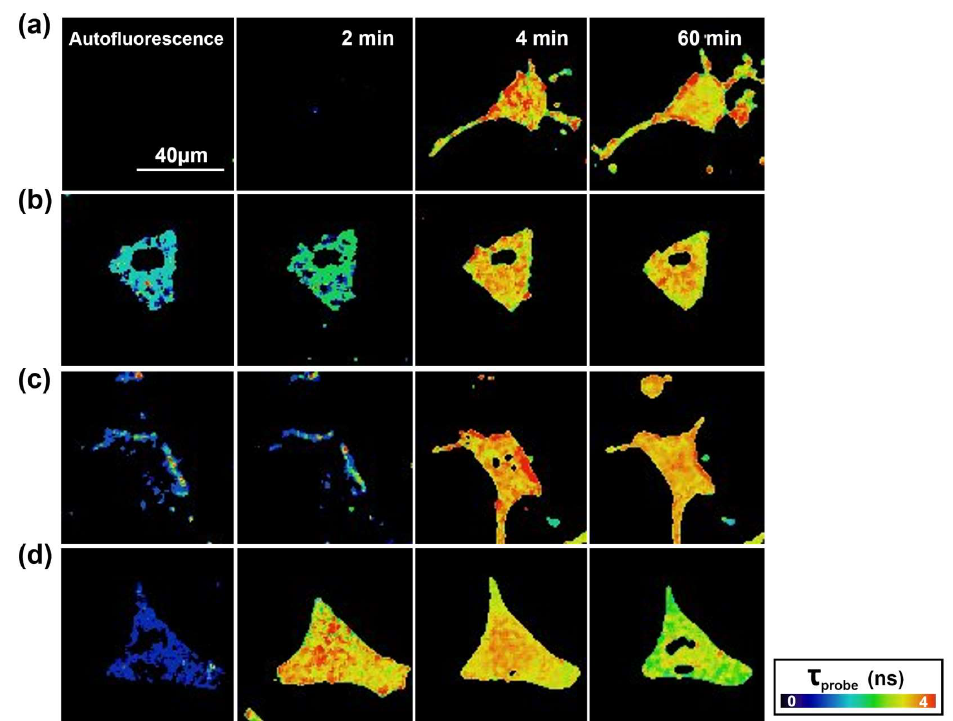
Figure 8. FLIM images of the released fluorophore after the fluorogenic reaction of GG-DNBS with biothiols in N2a cells without ( a ) and with the addition of Aβ42 aggregates, formed after incubating for 24 h ( b ) and 48 h ( c and d ). The pseudocolor scale represents the fluorescence lifetime of the probe, τ probe , between 0 and 4 ns.